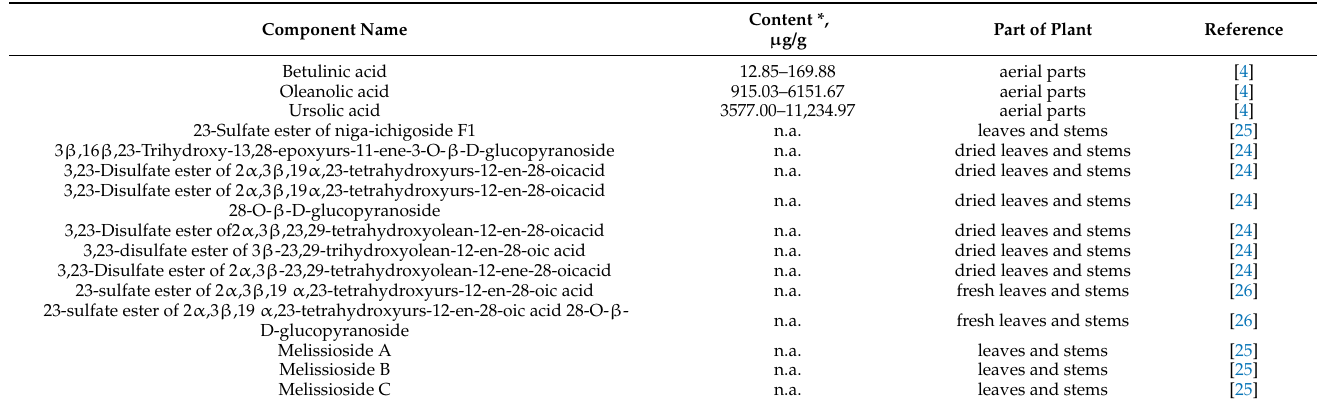
Table 2. Triterpenes from Melissa officinalis